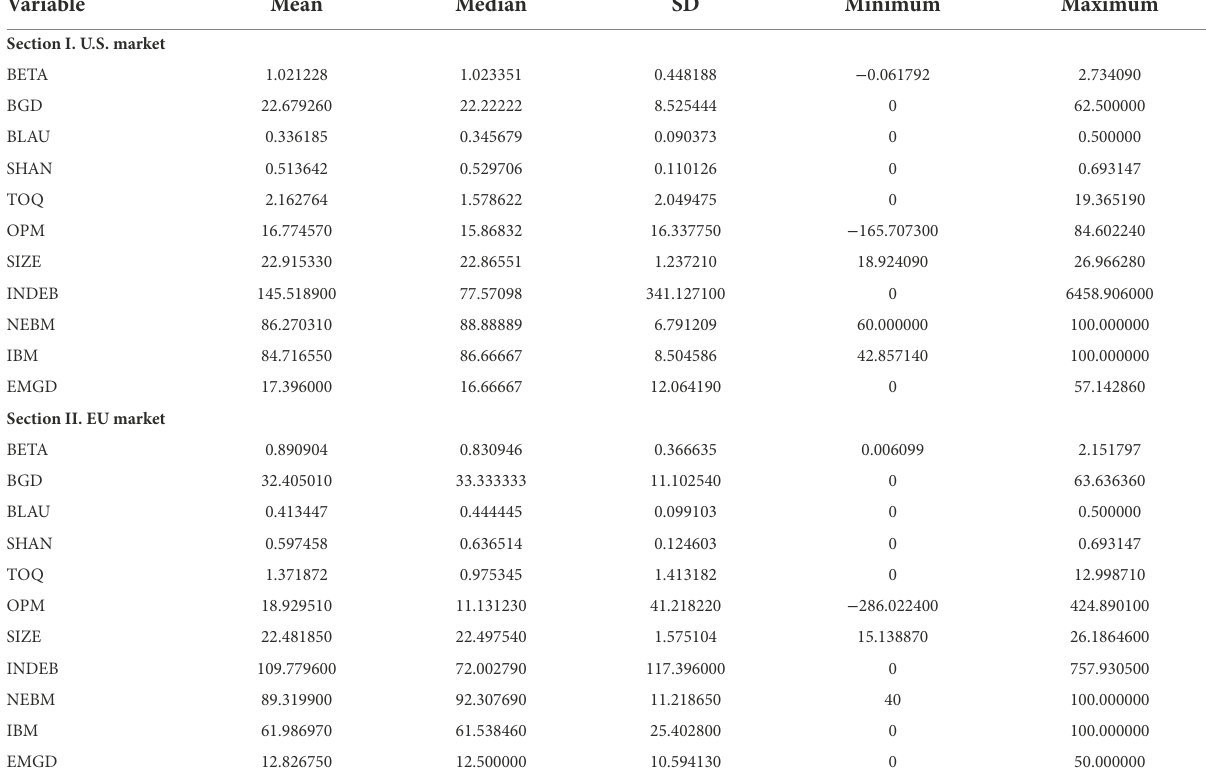
TABLE 4 Descriptive statistics of continuous variables.